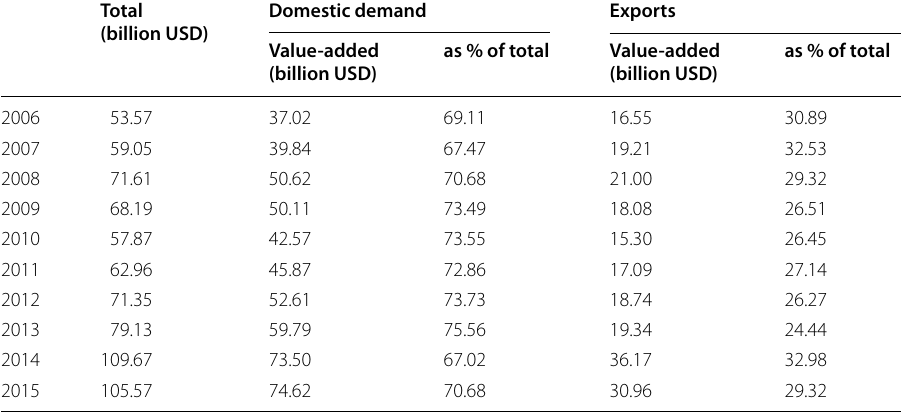
Table 3 Value-added embodied in domestic demand and exports in 2006–2015 Total Domestic demand Exports (billion USD)